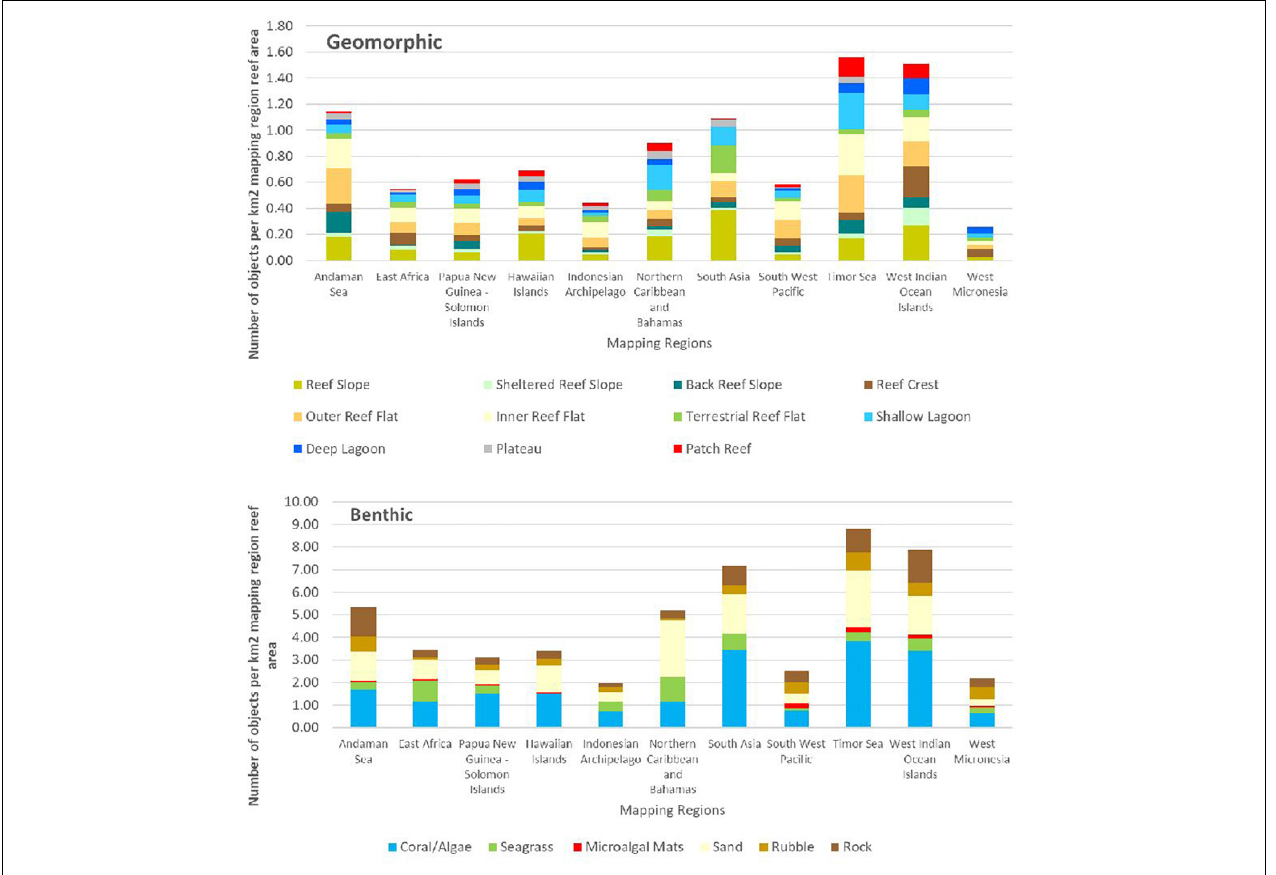
FIGURE 4 | Quantification of reference data segments. The number of geomorphic and benthic reference data segments per category, per region normalized for the extent of reef area within each mapping